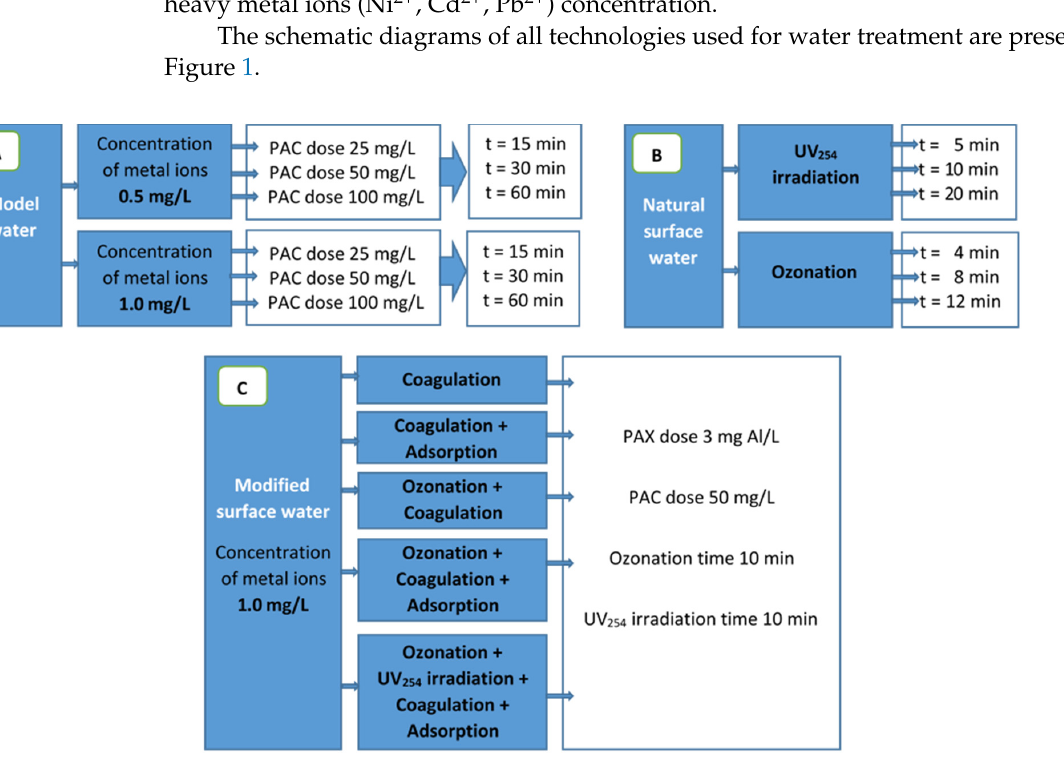
Figure 1. Schemes of treatment method applied to different types of analysed water: ( A )—model water, ( B )—natural surface water, ( C )—modified surface water; PAX—pre-hydrolysed polyaluminium chloride, PAC—powdered activated carbon.